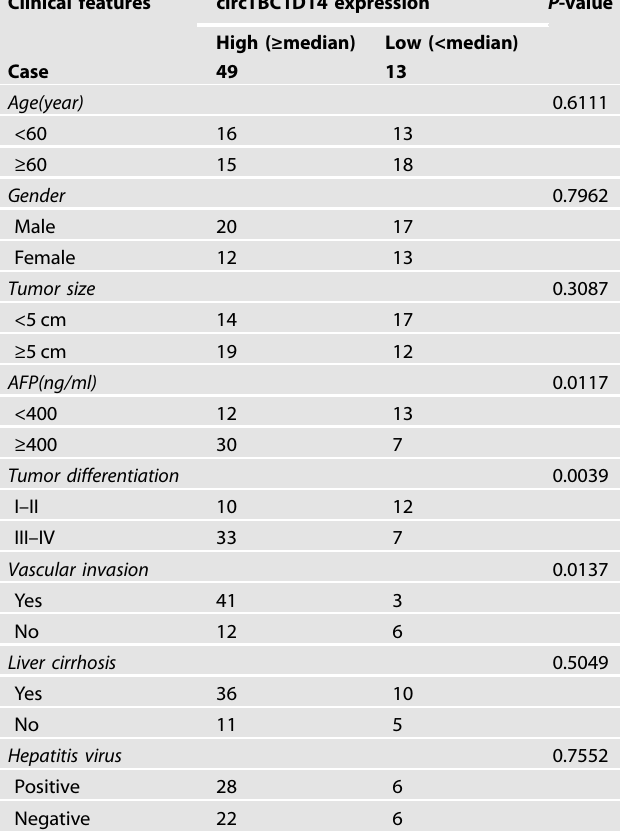
Table 2. Correlation between circTBC1D14 expression and clinicopathological features in HCC plasma samples ( n =